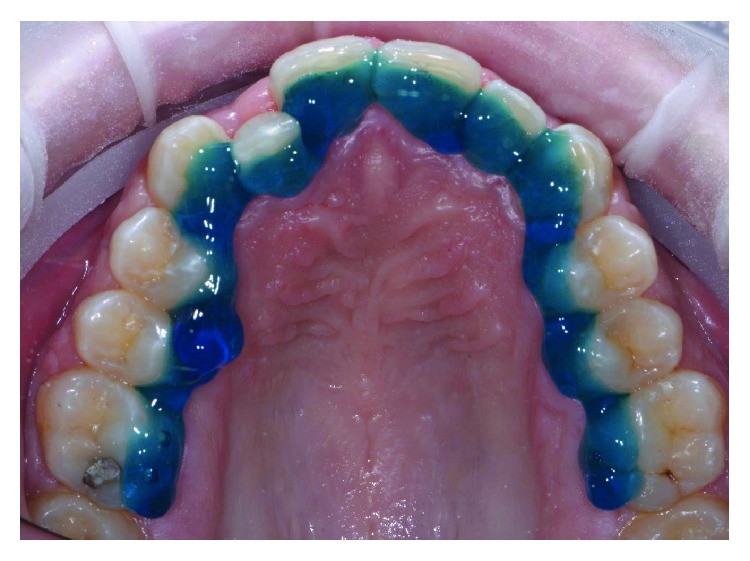
Etching procedure.